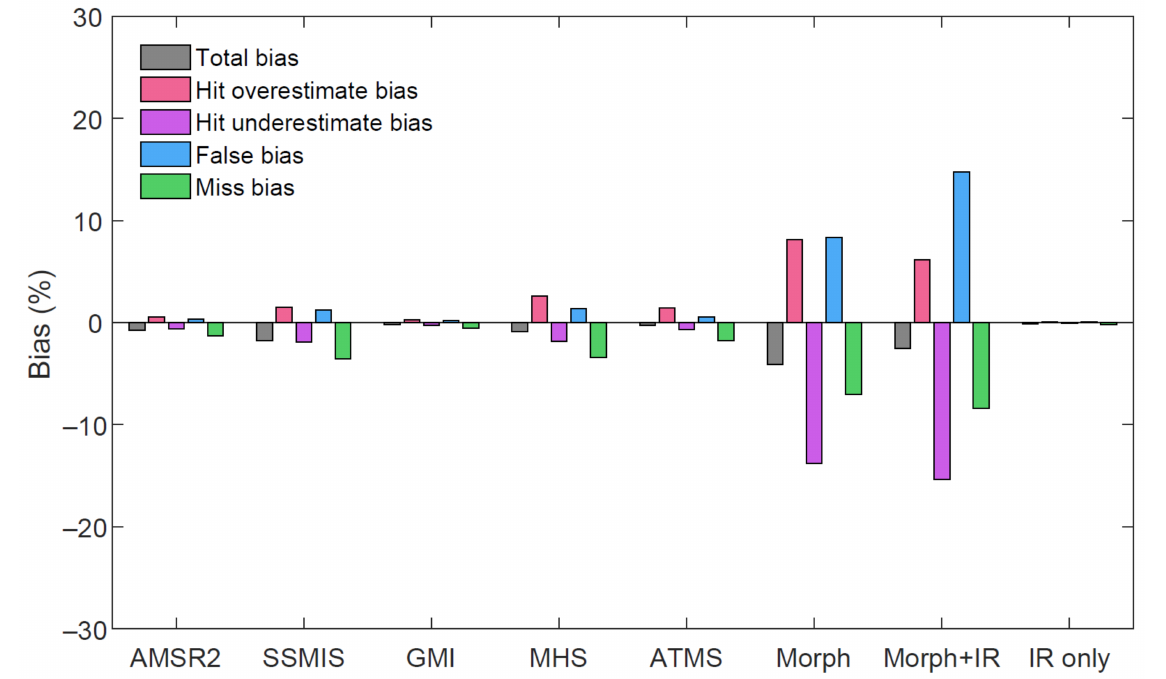
Figure 7. The total bias (TB), hit overestimate bias (HOB), hit underestimate bias (HUB), false bias (FB), and miss bias (MB) components for each input source used in IMERG over the Tunxi Watershed.